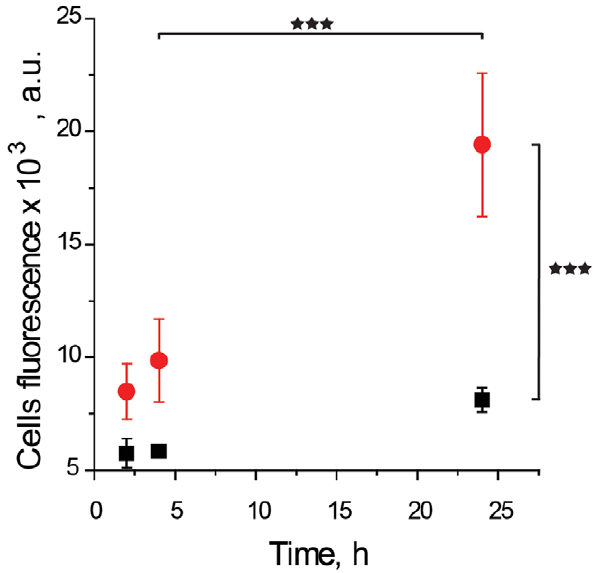
Figure 6. Time- and dose- dependent cellular internalization of the model fluorescent product, fluorescein, generated via SMEPT from its prodrug, FdG. Experimental conditions: 1 g/L enzyme in the polymer solution; initial concentration of FdG: 0.25 (red circles) and 0.025 (black squares) m g/mL. Presented results (mean 6 st.dev.) are average over at least 3 independent experiments, 3 replicates each.